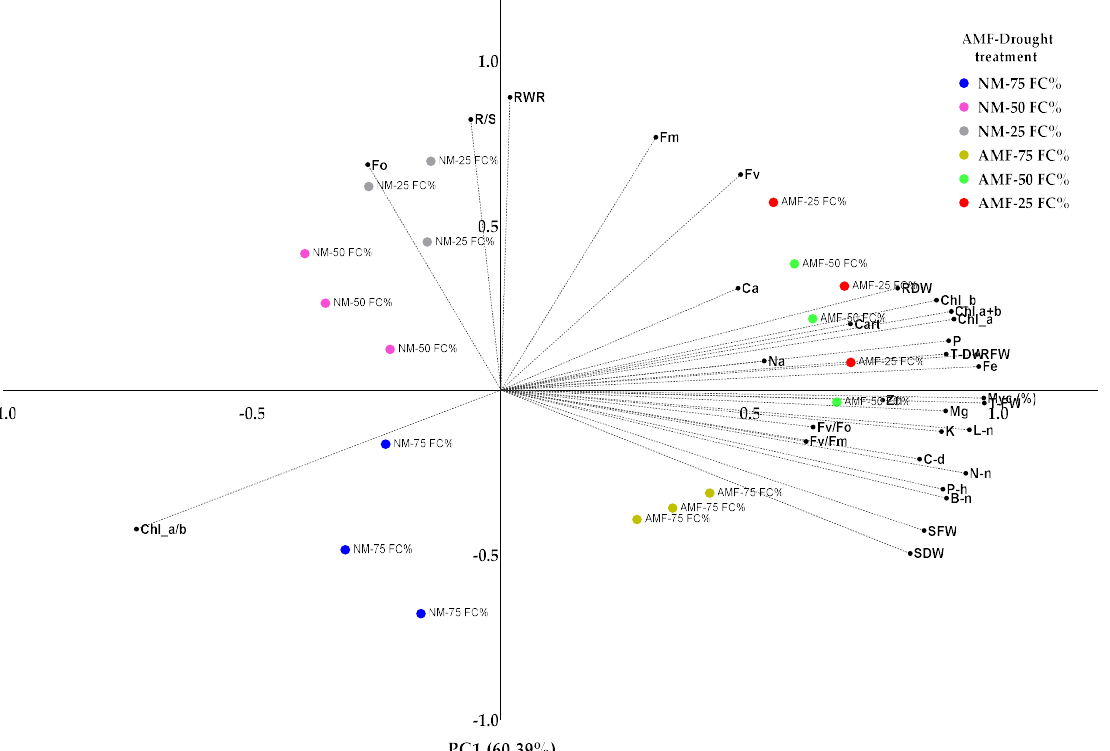
Figure 3. Biplot of principal components analysis (PCA) based on all measured parameters of C. spinosa plantlets exposed to various levels of water-deficit conditions (75, 50 and 25% FC) and AMF treatment. The blue contour lines assign the variables, and the six colored forms-points symbolize all different treatment groups. Myc (%) = Mycorrhizal colonization rate, MD (%) = Mycorrhizal dependency, P-h = Plant height, L-n = Leaves no., B-n = Branches no., N-n = Nodes no., C-d = Collar-diameter, TFW = total fresh weight, TDW = Total dry weight, SFW = shoot fresh weight, SDW = Shoot dry weight, RFW = Root fresh weight, RDW = Root dry weight, R/S = Root-to-shoot ratio, RWR = Root weight ratio, K = Potassium, Mg = Magnesium, Fe = Iron, P = Phosphorus, Zn = Zinc, Na = Sodium, Ca = Calcium, Chl a = Chlorophyll a, Chl b = Chlorophyll b, Chl a + b = Total chlorophyll, Chl a / b = Chlorophyll a/b, Cart = Carotenoids, F o , F v , F m , F v /F m and F v /F o = Chlorophyll fluorescence indices.